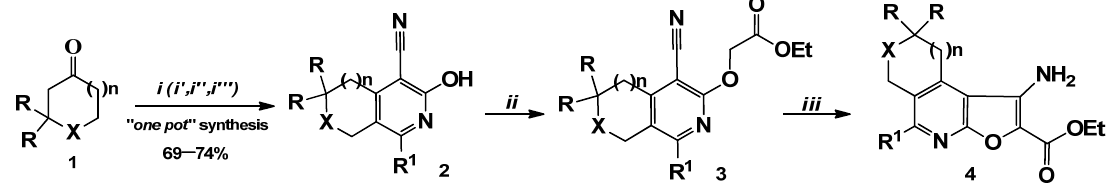
Figure 2. The structure of starting cyclic ketones 1a – c . 1a : X = CH 2 , n = 0, R = H, b : X = CH 2 , n = 1, R = H, c : X = O, n = 1, R = Me.